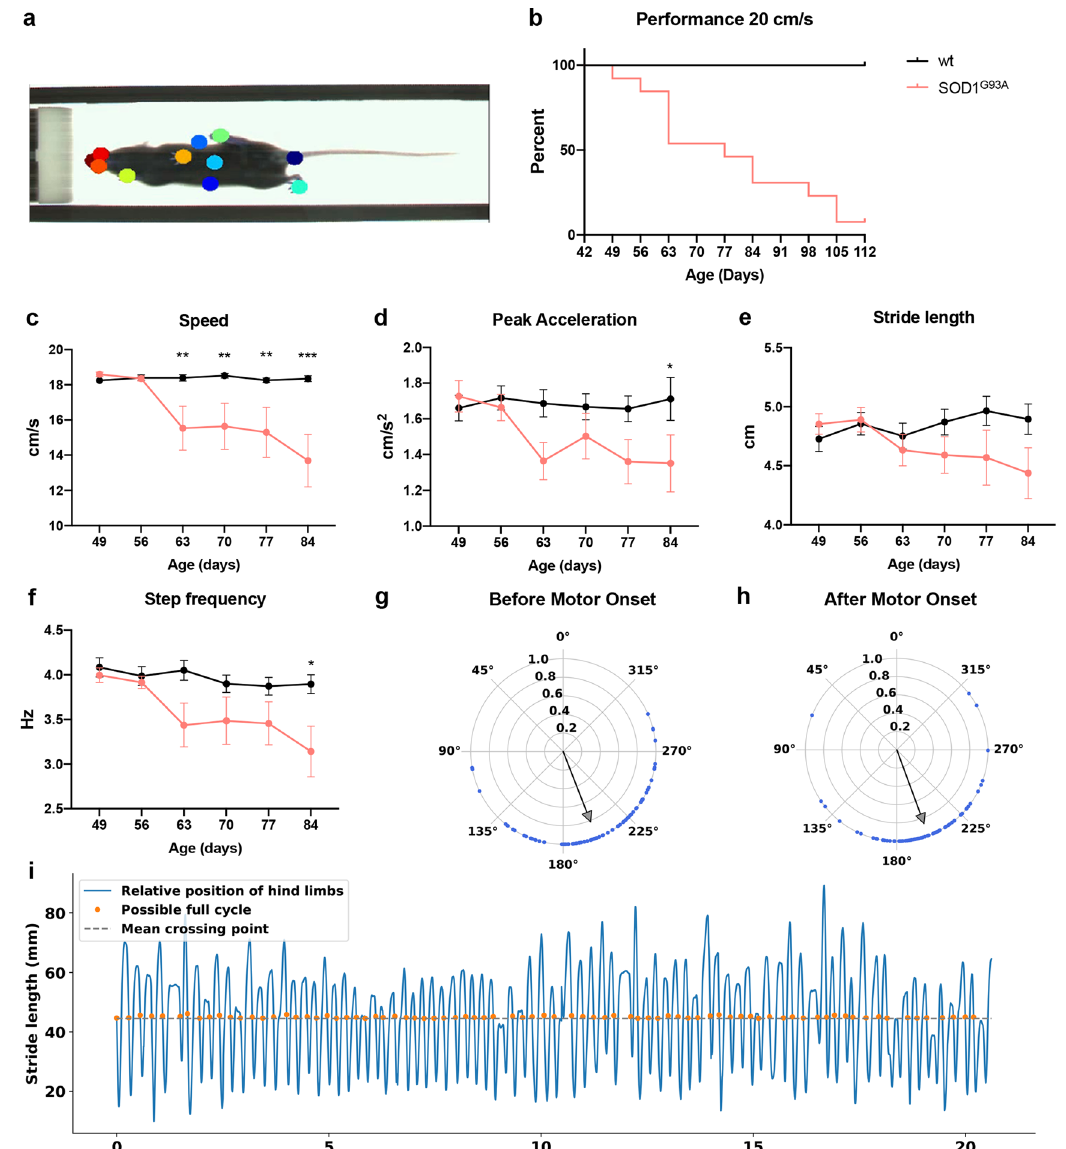
Fig. 5 SOD1 G93A mice between postnatal day 49 and 63 show locomotor de fi cits. a Example of tracking approach performed on recorded videos with DeepLabCut analysis tool. Colored circles show digital markers placed on the animals to extrapolate tracks for analysis. b Performance of wild-type (wt) and SOD1 G93A mice on treadmill at a speed of 20 cm/s. Percentage shows that between P49 and P63 46.2% of the SOD1 G93A mice cannot perform the task (median = 77; two-tailed Gehan – Breslow – Wilcoxon test, P = 0.0003, Chi square = 12.92, df = 1; N = 11 independent mice per condition). At a longitudinal time scale, mice show a progressive reduction of speed (two-way ANOVA and Dunnett ’ s post hoc, F (5, 105) = 3.020, P63 P = 0.0060, P70 P = 0.0085, P77 P = 0.0027, P84 P = 0.00009; wt N = 8 mice, SOD1 G93A N = 15 mice) compared to control mice ( c ) as well as a progressive reduction in peak acceleration ( d ) (two-way ANOVA and Dunnett ’ s post hoc, F (5, 126) = 0.9761, P84 P = 0.0468; wt N = 8 mice, SOD1 G93A N = 15 mice), stride length ( e ) (two-way ANOVA and Dunnett ’ s post hoc, F (5, 105) = 1.441, P = 0.2157; wt N = 8 mice, SOD1 G93A N = 15 mice) and step frequency ( f ) (two-way ANOVA and Dunnett ’ s post hoc, F (5, 105) = 1.951, P84 P = 0.0167; wt N = 8 mice, SOD1 G93A N = 15 mice) when compared to wild-type mice. Hindlimb left-right alternation was compared before ( g ) and after ( h ) Onset of locomotor phenotype. Blue dots represent single steps of a given animal before and after onset. Gray arrows depict mean vectors of the average direction of all steps. Phase values at 180 degrees correspond to strict alternation. Stride analysis in ( i ) shows the out of phase pattern of the hindlimbs during locomotion which was extracted for coordination analysis. In all graphs, data are presented as mean values ± SEM. Source data are provided as a Source Data fi